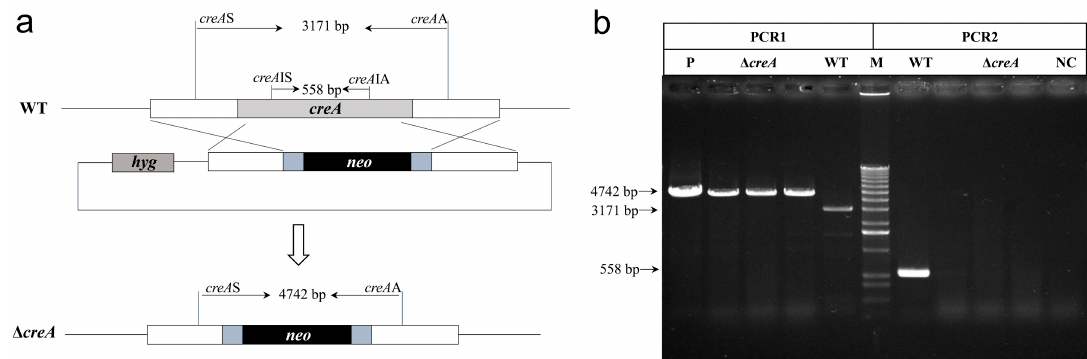
Figure 2. Verification of the creA disruption mutant. ( a ) Schematic diagram of the creA gene knockout mediated by homologous recombination. hyg , hygromycin B resistance gene expression cassette; neo , geneticin resistance gene expression cassette. ( b ) Polymerase chain reaction (PCR) analysis of the creA disruption mutant using the primer pairs creA S / creA A (PCR1) and creA IS / creA IA (PCR2). M, 1000-bp DNA ladder; WT, wild type; ∆ creA , creA disruption mutant; P, positive control with the plasmid pAg1- HygNeo - ∆ creA as the template; NC, negative control.